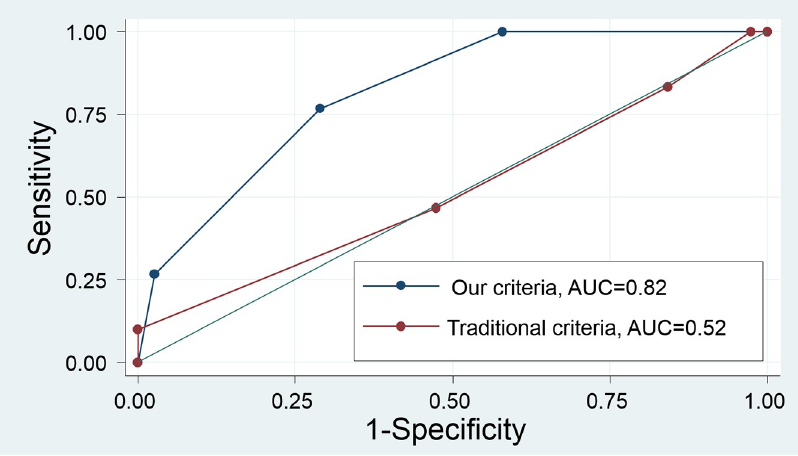
Fig 3. The ROC curve to compare our new proposed criteria (blue line) with the old criteria (red line). Our new proposed criteria were significantly superior to the old criteria (P < 0.001). Note. AUC; area under the curve.